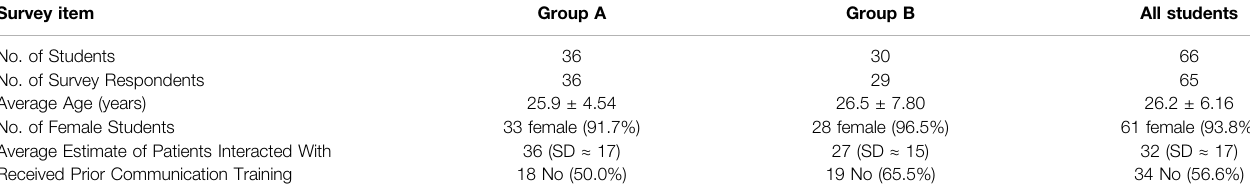
TABLE 1 | Demographic information for students in the Message Production Trends study. Survey